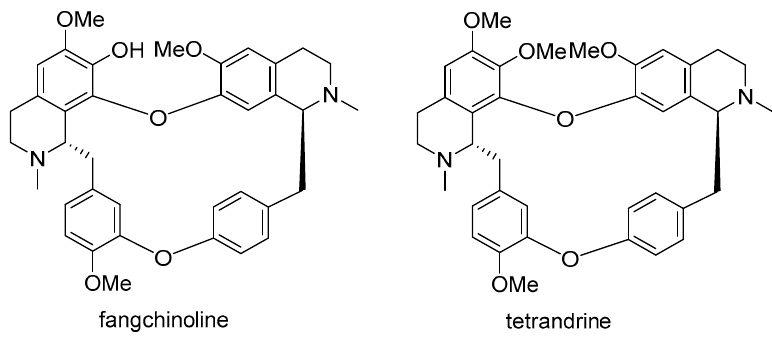
Figure 1. The structure of fangchinoline and tetrandrine.